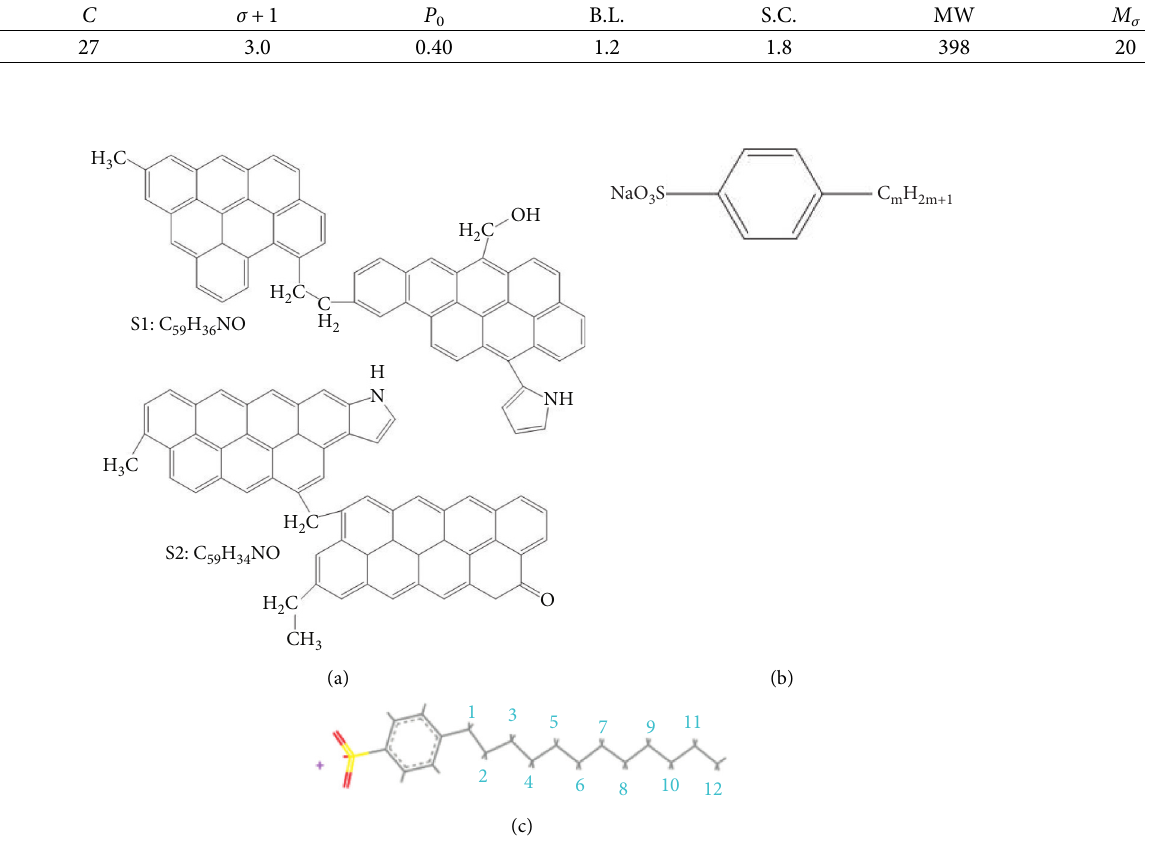
Figure 1: (a) Molecular structures S1 and S2 of Jincheng anthracite. (b) Linear alkylbenzene sulfonates with different hydrophobic carbon chain lengths ( m � 8, 10, 12, 14, 16, 18). (c) Sodium dodecylbenzene sulfonate when m �